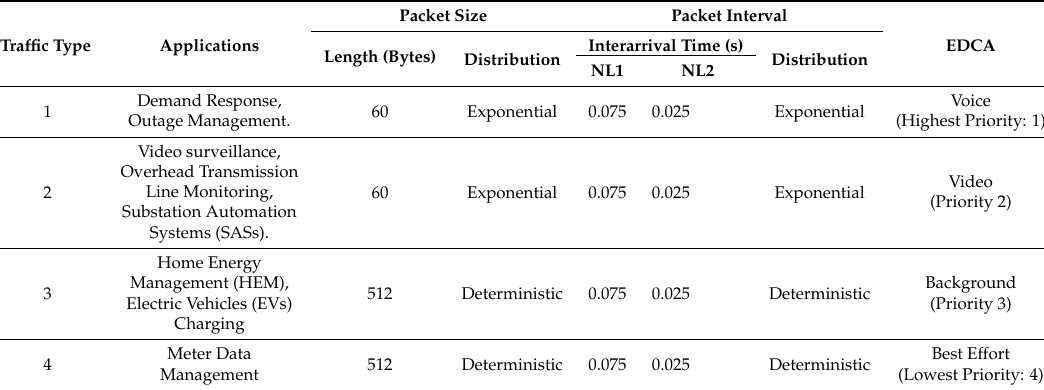
Table 4. Applications classification, distributions, and parameters. NL, Network